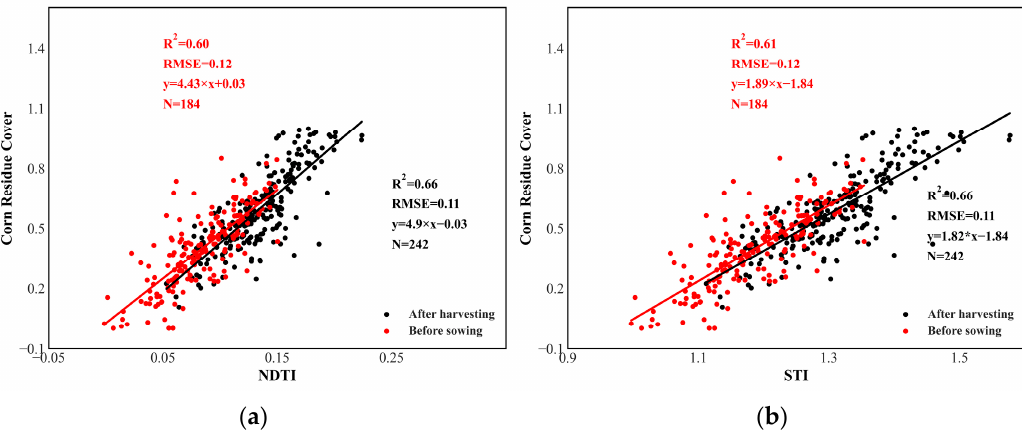
Figure 8. Coe ffi cient of determination between NDTI and STI with measured CRC after harvesting ( a ) and before sowing ( b ). ( a ) and before sowing ( b